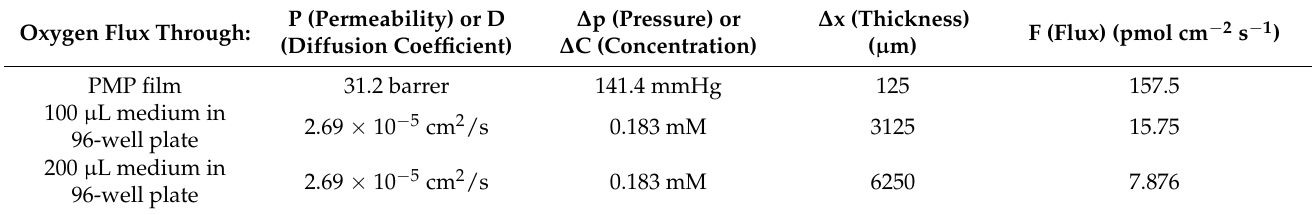
Table 2. Overview of input parameters (light grey) and calculated oxygen flux (dark grey) through the PMP film compared to 100 µ L medium and 200 µ L medium in regular 96-well plates. See Supplementary Information Section S4 for